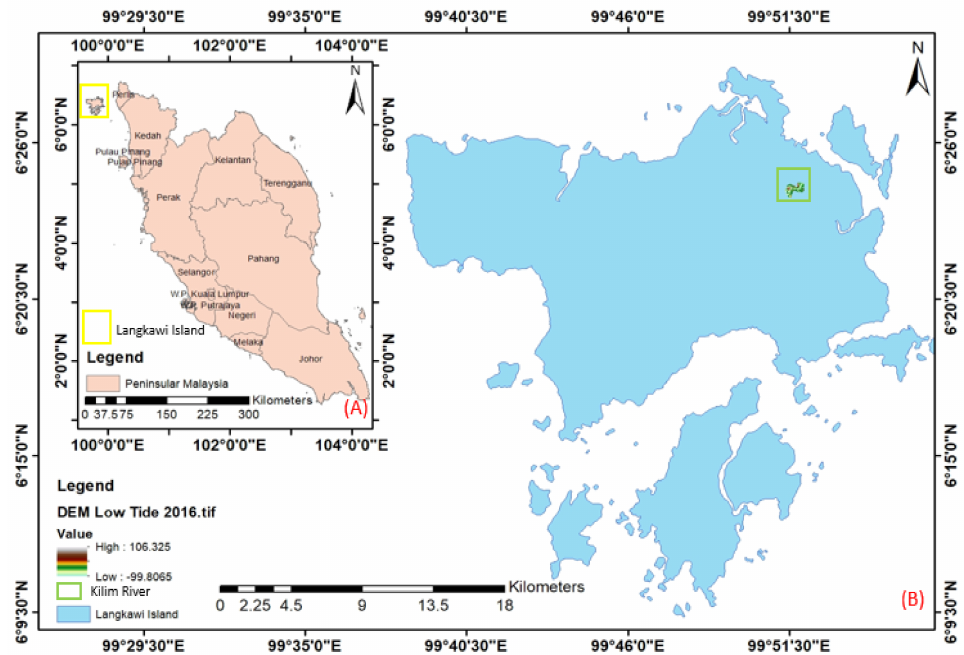
Figure 1. ( A ) Location of the study area in Malaysia’s Peninsular (shown by the small yellow square); ( B ) location of the Kilim River as the primary study area displayed along with ground control points (GCPs) location in the orthophoto image captured by the